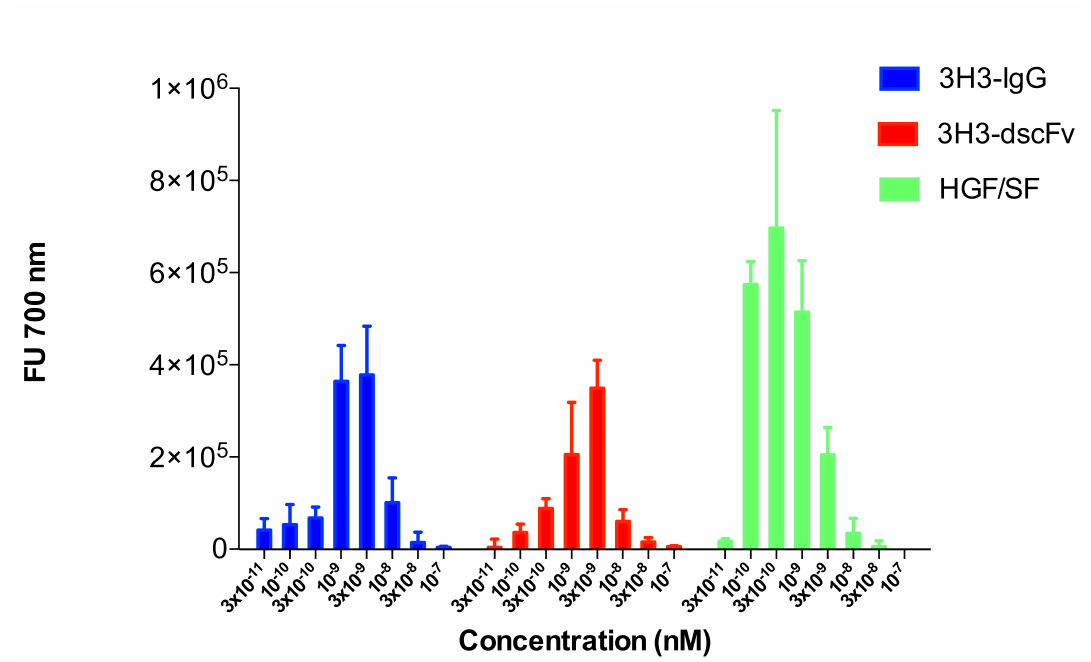
Figure 9. Cell motility assay (migration of SKOV-3 cells). A modified Boyden chamber assay was used to analyze stimulation of cell motility in SKOV-3 cells. HGF/SF served as positive control and showed the typical bell-shaped dose-response curve with activity down to 100 pM. The intact 3H3 antibody (3H3-IgG) and the 3H3 diabody (3H3-dscFv) also showed a bell-shaped dose-response curve. The diabody stimulated cell migration down to a concentration of 100pM.